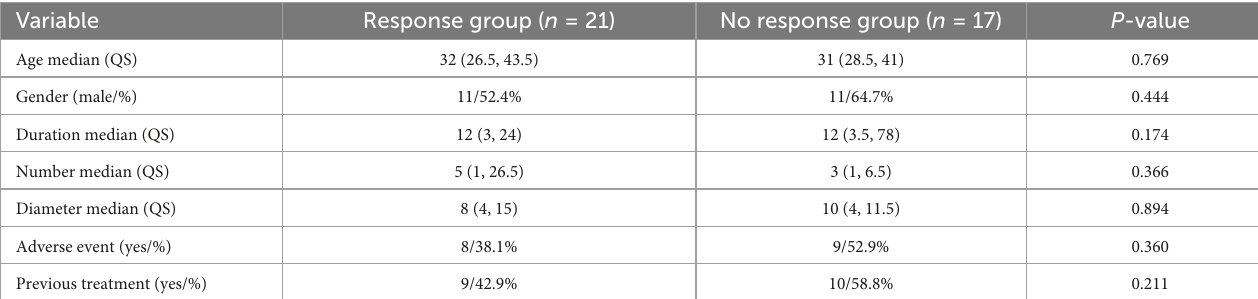
TABLE 1 Demographics and clinical characteristics of 38 patients with plantar warts: A subgroup